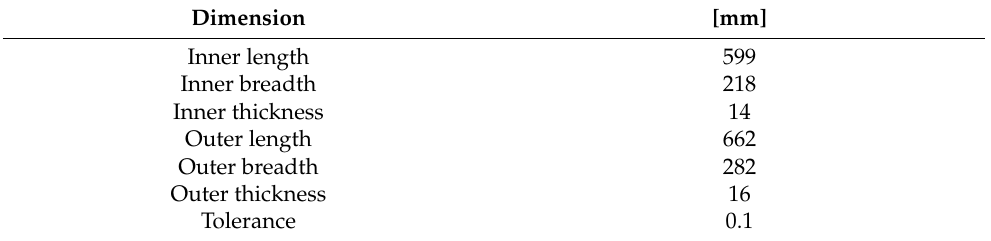
Table 2. Dimensions of the FTFC test panels.